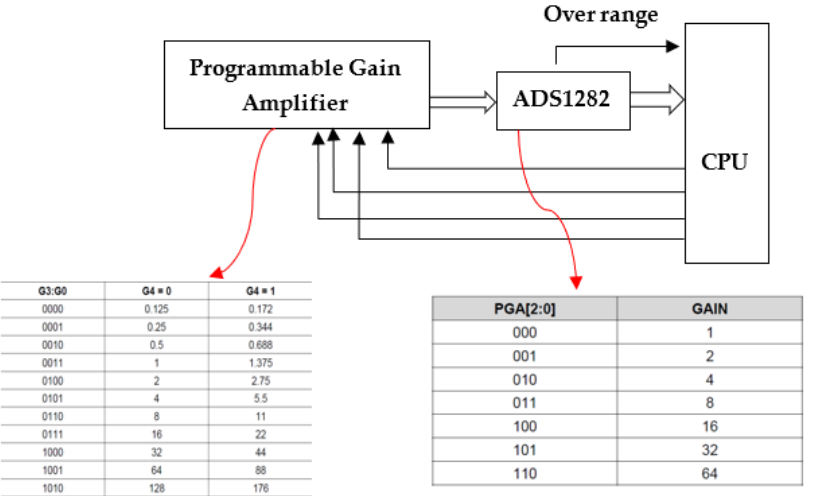
Figure 15. Schematic diagram of the gain control.